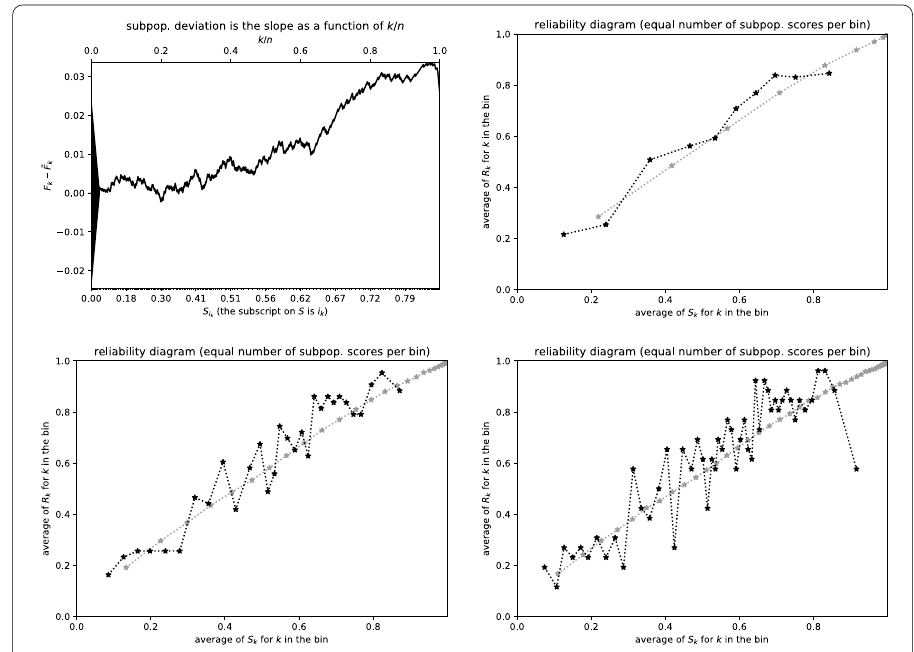
Fig. 13 Sunglasses, with scores being the probabilities; n = 1300; Kuiper’s statistic is 0.03597 /σ = 2.935 , Kolmogorov’s and Smirnov’s is 0.03365 /σ = 2.745 . The reliability diagrams with only 10 or 30 bins each fail to resolve the very high deviation for probabilities greater than 0.9 (unlike the diagram with 50 bins)—the smaller numbers of bins average away interesting behavior, without warning. The scalar summary statistics detect some statistically significant deviation, yet both are blind to the serious deviation for the highest scores that the plot of cumulative differences displays prominently; the steep drop at the highest scores in the cumulative plot has little to no effect on the Kolmogorov-Smirnov or Kuiper metrics,